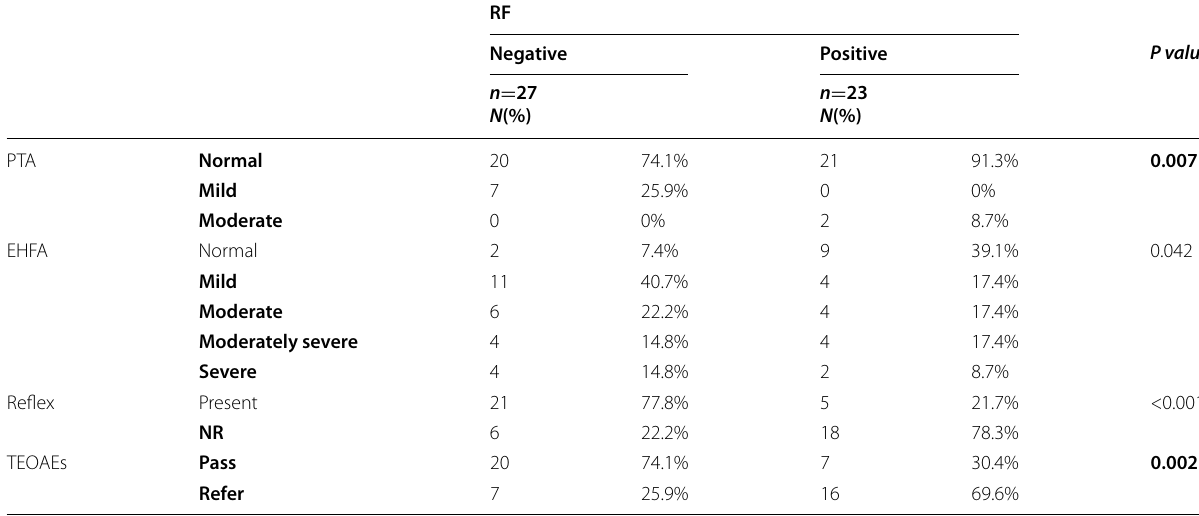
RF rheumatoid factor, ACCP anti-cyclic citrullinated peptide, DAS disease activity score, PTA pure tone audiometry, EHFA extended high-frequency audiometry, AR acoustic reflex, TEOAEs transient evoked oto-acoustic emission, NR no